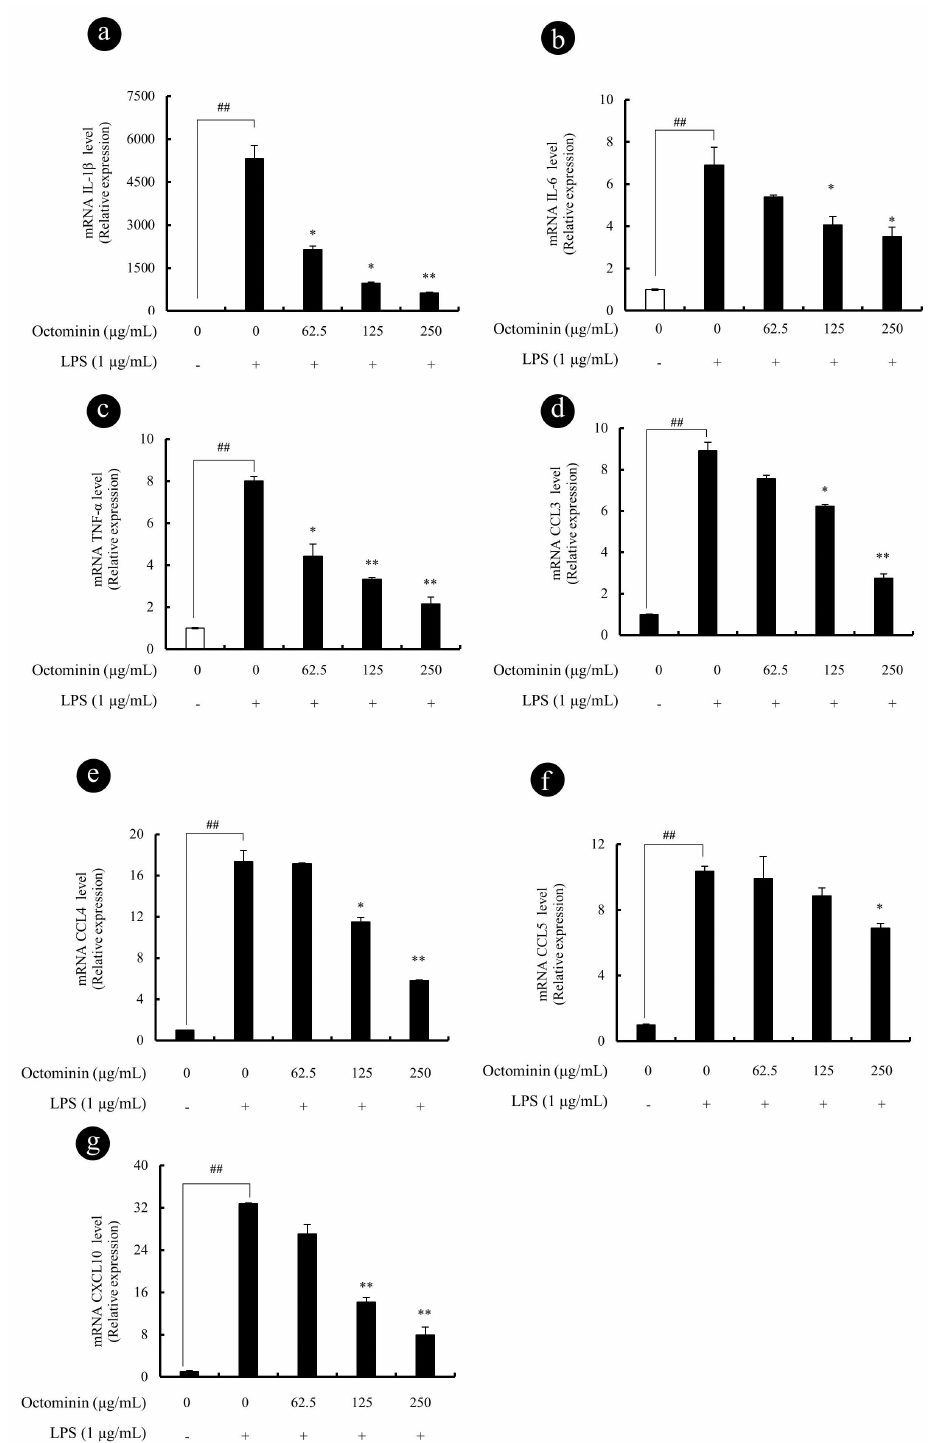
Figure 4. Octominin inhibits the production of pro-inflammatory cytokines and chemokines in the LPS activated RAW 264.7 macrophages. Cells were incubated for 6 h before RNA isolation. Relative expression of IL-1 β ( a ), IL-6 ( b ), TNF- α ( c ), CCL3 ( d ), CCL4 ( e ), CCL5 ( f ), and CXCL10 ( g ) was measured using qPCR with GAPDH as the internal reference gene. Experiments were triplicated to evaluate the data, and the mean value is expressed as ± SD. mRNA significance relative to the vehicle-treated control group was calculated using the Mann–Whitney U test ( # < 0.05 and ## < 0.01) or LPS-treated group (* < 0.05 and ** <